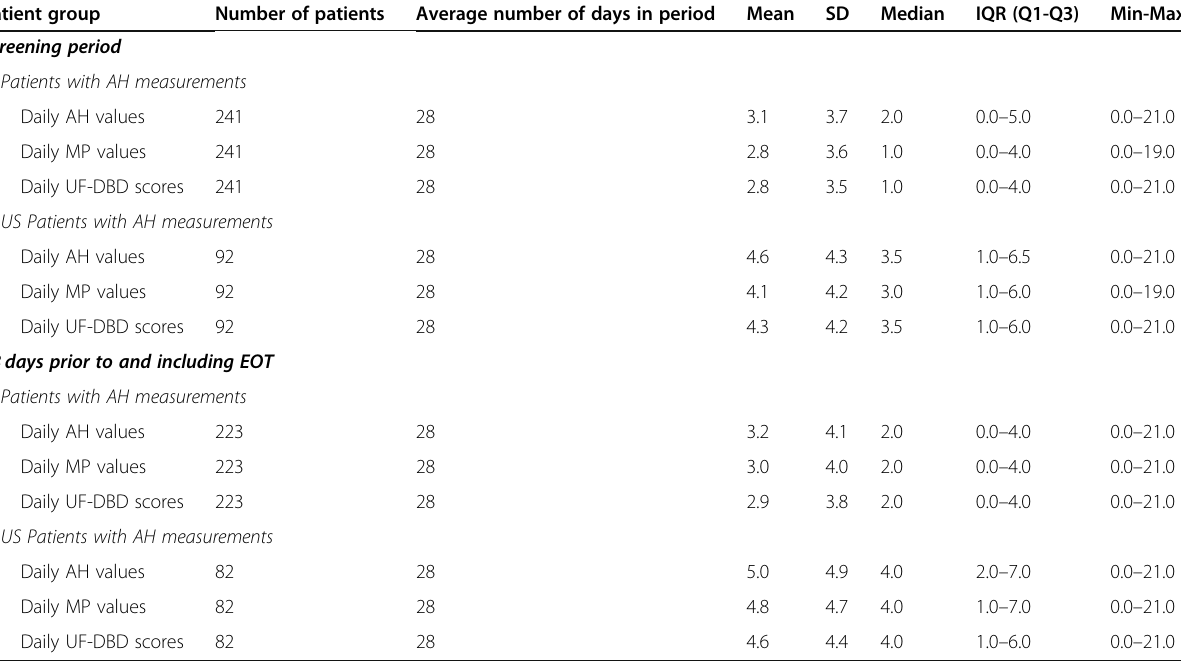
Table 6 Absolute frequency of missing daily AH, MP values, and daily UF-DBD scores per patient Patient group Number of